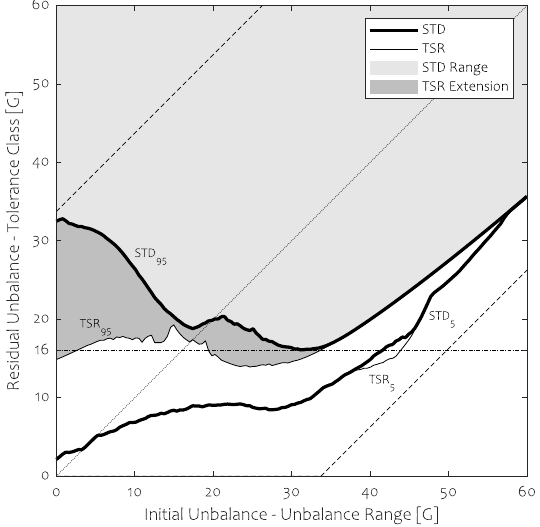
Figure 7. Lines: Influence of initial unbalance on residual unbalance following the standard configuration of Table 1 and afore-stated speed profile. Area: Valid initial unbalance range for a given tolerance